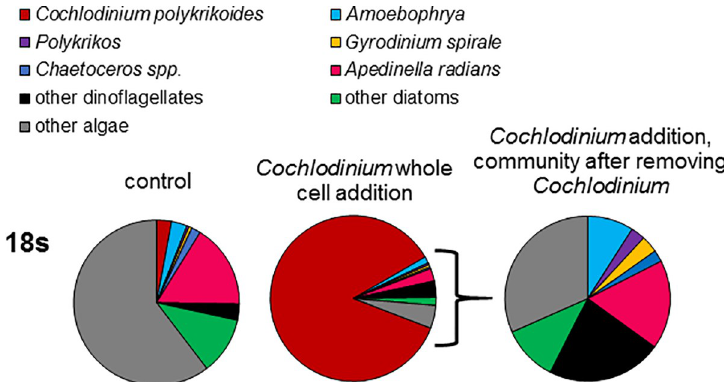
Fig 7. Relative abundances of algal (18S) sequences for the experimental control, and the Cochlodinium polykrikoides culture whole cell addition treatment during an experiment conducted using the natural phytoplankton community of Old Fort Pond, NY.